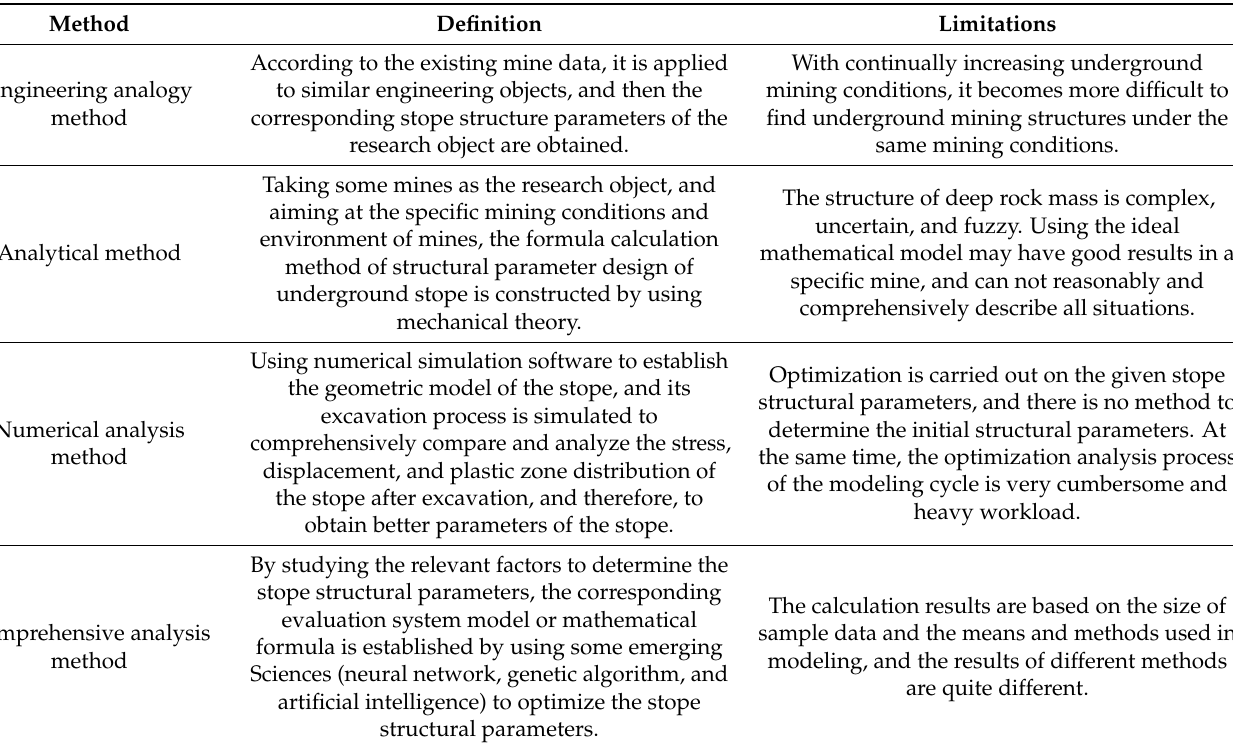
Table 1. Design methods for designing stope structural